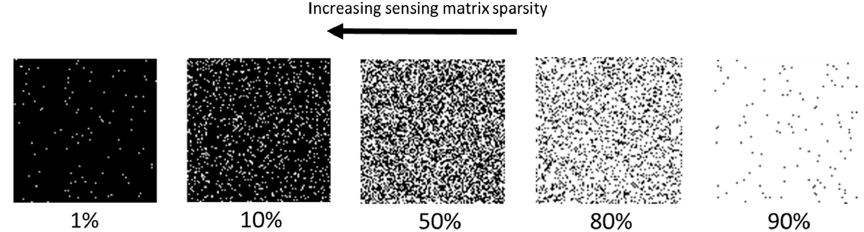
Figure 4. Visualisation of the sparsity of individual patterns of sensing matrices. Sparser patterns